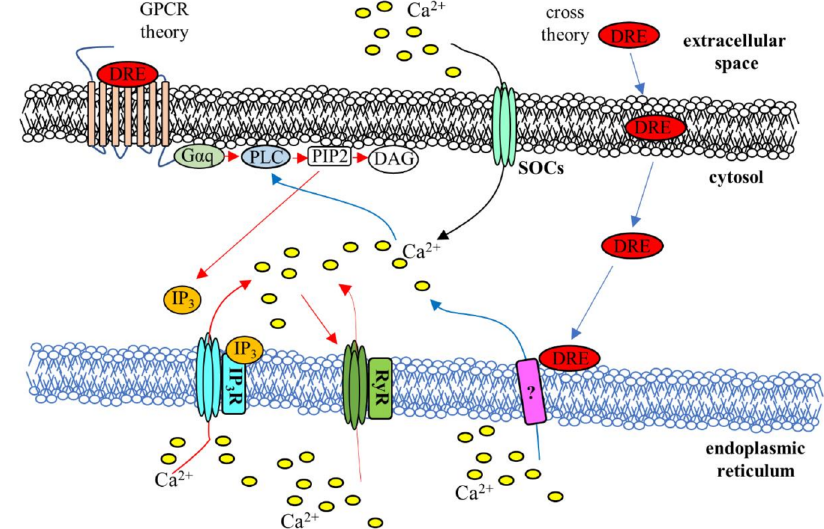
Figure 8. Schematic illustration of the putative mechanisms for DRE-induced Ca 2+ signaling. The “cross theory” (blue arrows) and the “GPCR theory” (red arrows) have been proposed to explain the mechanisms underlying the Ca 2+ increase induced by exposure to DRE: See the text for a detailed description. DRE, dandelion root extract; IP3, Inositol trisphosphate; IP3R, Inositol trisphosphate receptor; RyR, Ryanodine receptor; DAG, diacylglycerol, PIP2, phosphatidylinositol 4,5-bisphosphate; PLC, phospholipase C; G α q, alpha subunit of Gq; SOCs, store-operated Ca 2+ channels, “?” indicates unknown